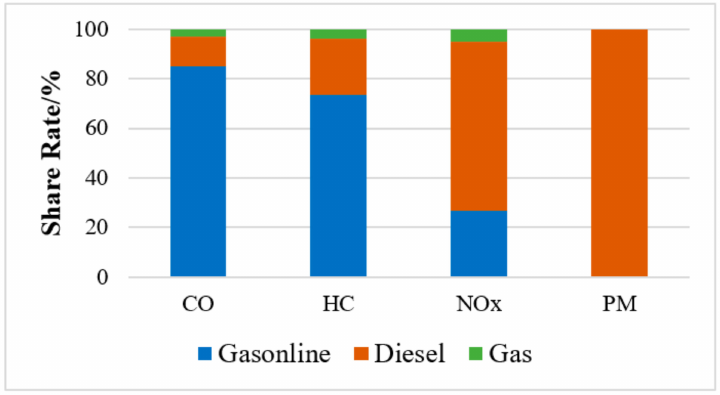
Figure 2. Vehicle emission share rate according to fuels